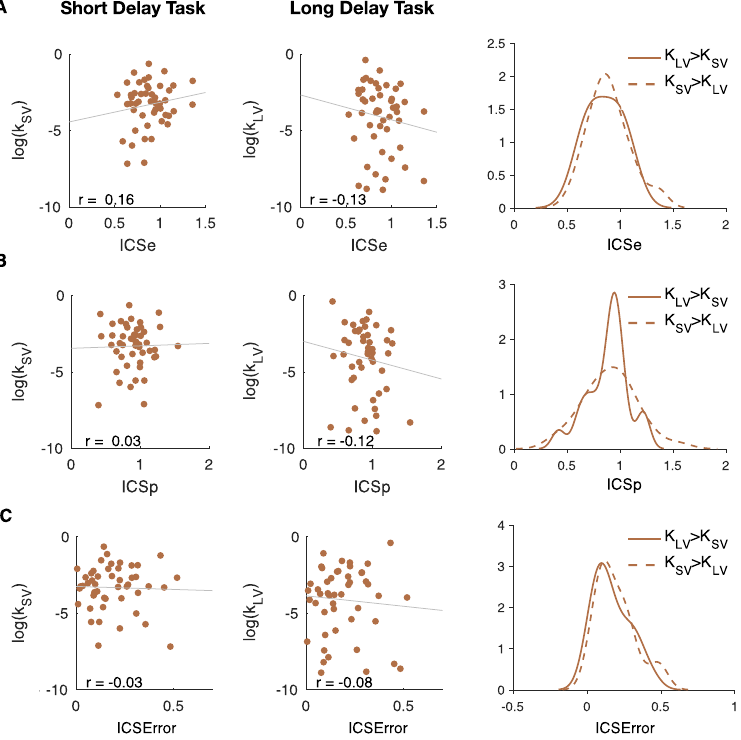
Figure 4. ( A – C ) First two columns represent correlations between discount factors (in short delay and long delay tasks, y-axis) with ICSe , ICSp , and ICSError (x-axis). Each circle is one subject ( N = 49 ). Pearson’s r is reported on the figure (all p > .05 ). Best linear fit line ( y ∼ x ) is displayed. There was no evidence of correlation between any ICS measure and discount factor. The rightmost column represents kernel density estimations of ICSe and ICSp as proxies for ICS and ICSError split by positive or negative difference between discount factor in short and long delay tasks. There was no significant difference in internal clocks between subjects who appear more impulsive in the seconds task than the days task ( K SV > K LV ) and those, who appear more impulsive in the days task than the seconds task ( K LV > K SV ). These results did not support our first hypothesis that subjects who appear more impulsive in the seconds task than the days task will have fast internal clocks and vice versa.